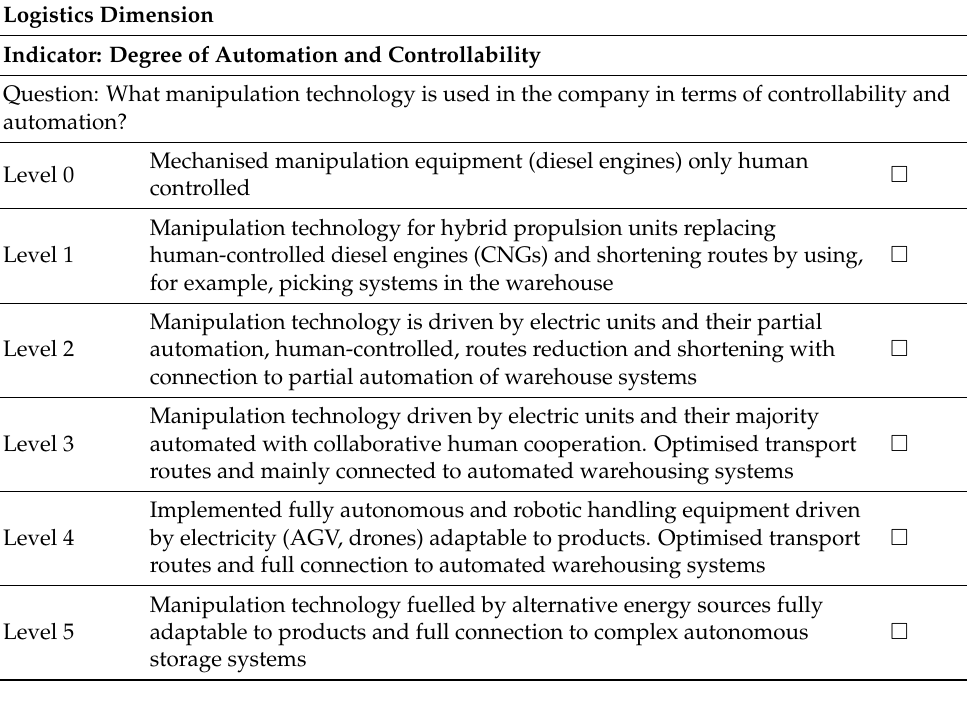
Table A3. An example of a question for evaluating the logistics dimension.